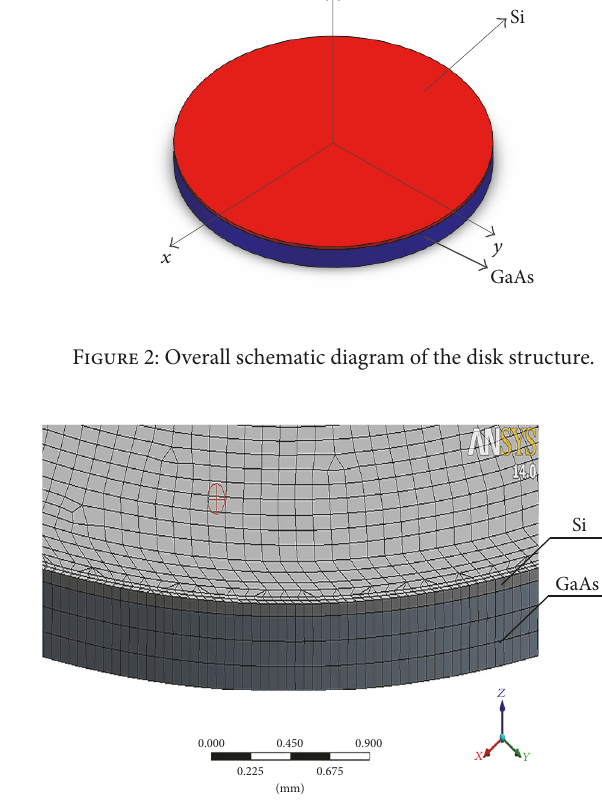
Figure 3: The schematic diagram of the local finite